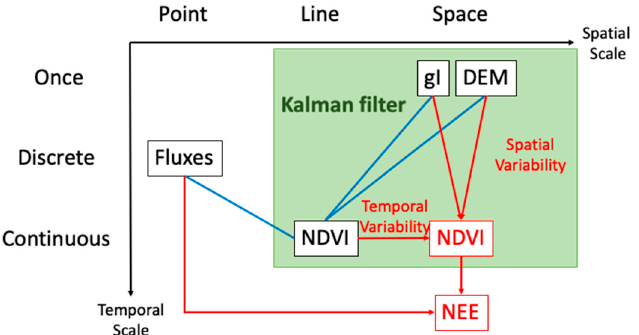
Figure 4. The structure of the multiscale data integration. The black boxes represent different types of datasets (fluxes, tram NDVI, gI) at different spatial and temporal scales. The red boxes represent the target variables to estimate; i.e., spatially and temporally continuous NDVI and NEE. The blue lines represent the correlations obtained from the datasets. The red lines represent the estimation based on those datasets and correlations.